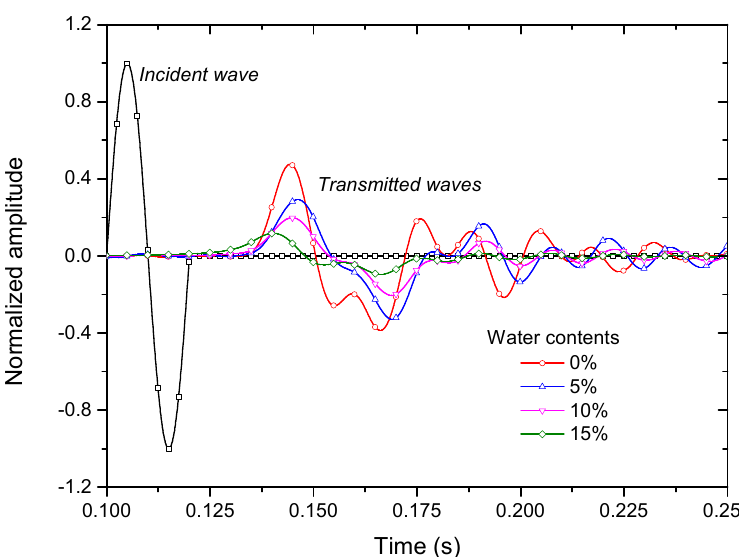
Figure 10. The incident P wave and transmitted waves (P-wave component) after propagating through four parallel filled joints with an identical spacing of 50 m considering different water contents. The incident P wave has the frequency of 50 Hz and the incident angle of 20°.